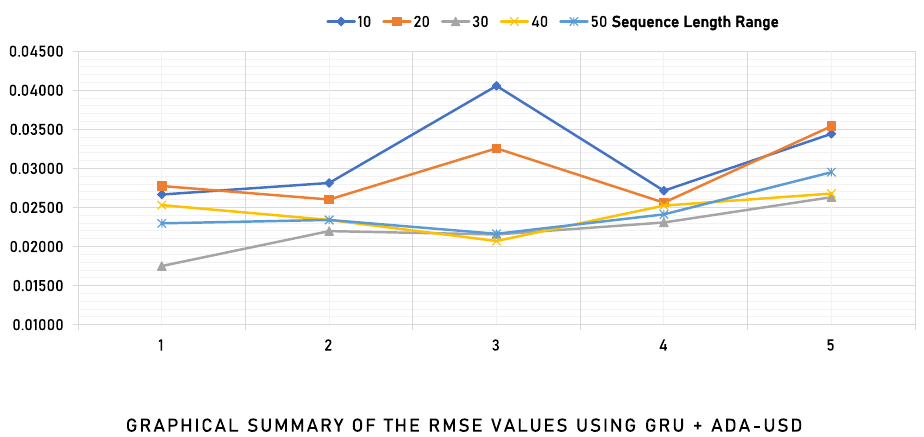
Fig. 13 A graphical summari- zation of the reported results using GRU and “Cardano USD (ADA-USD)”